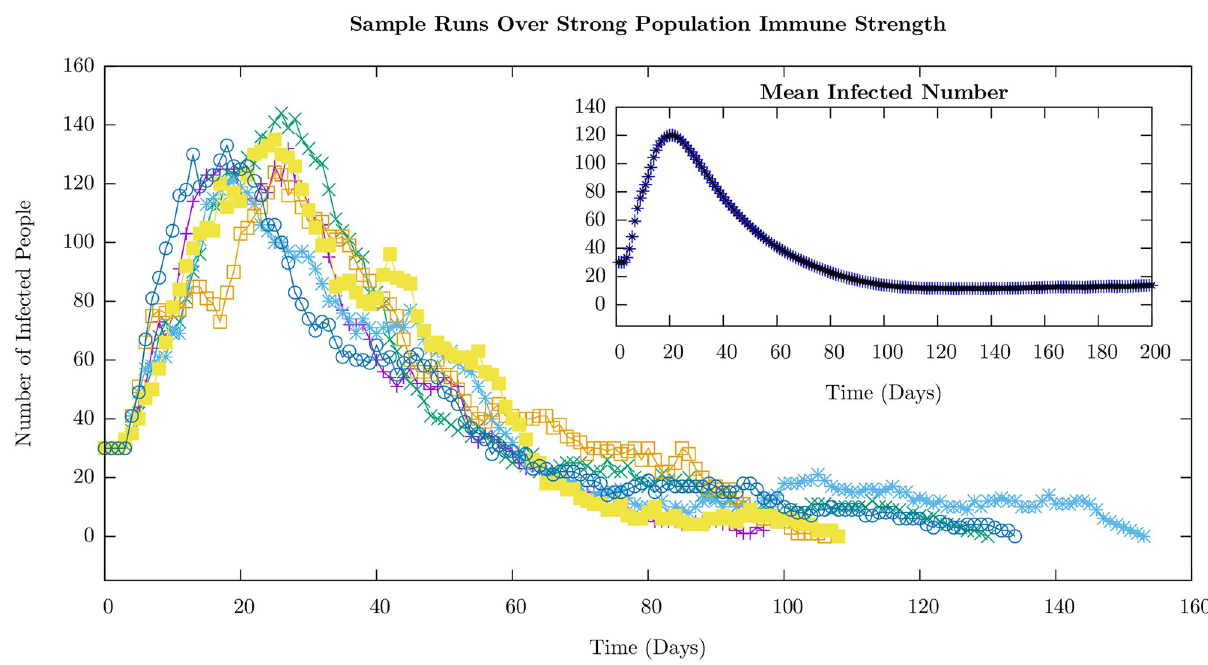
Fig 4. Plots corresponding to Fig 3 for the infected (the sum of exposed and infectious) agent number time series, with I i 2 [2, 6], a case of strong immune strength corresponding to immunization prior to the onset of the infection. Individual sample runs are shown with the ensemble average taken over 10,000 runs in the inset. This level of immunity leads to slow time scales for the rate of infection transmission between individuals compared to the duration before which an infectious individual recovers. The inter-cohort spread, through the weak, intermediate connections, is slower still and so we see an overall decay of the number of infectious agents. One sees smaller peaks punctuating the overall decline occurring randomly in time. The statistics of where the first peak occurs is shown in Fig 5(b). The other parameters used in the simulation are given in Table 1.